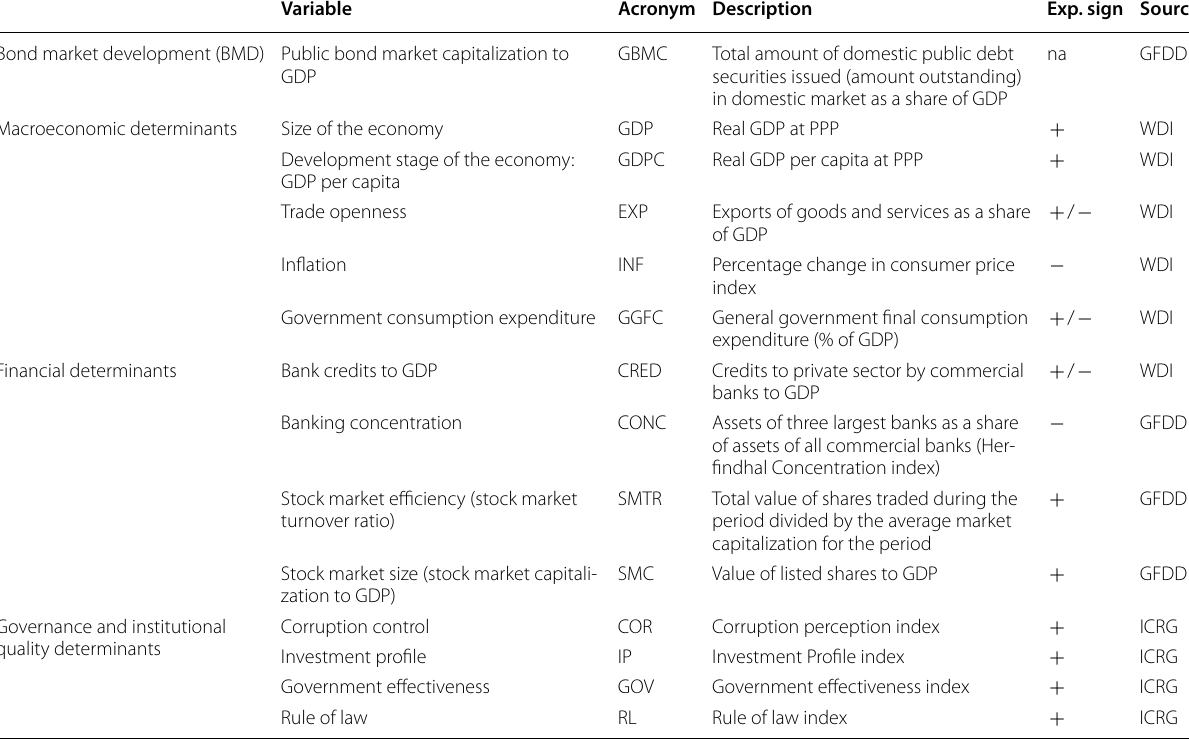
Table 1 Variables and data